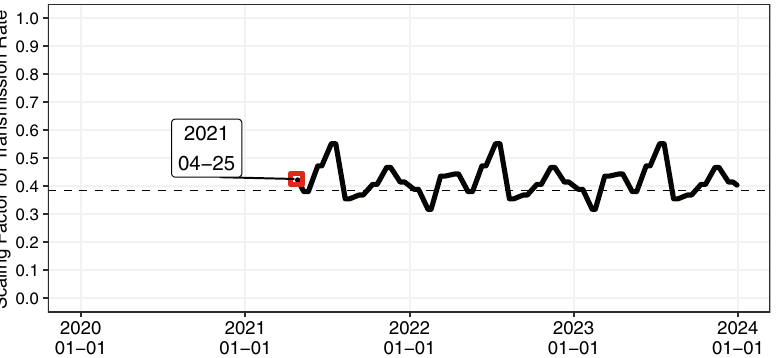
Figure 1. Simulation settings of the effectiveness of the non-pharmaceutical interventions. The simulations were started on April 25, 2021. The dashed line 1 / R 0 corresponds to an effective reproduction number with the value of one. The effective reproduction number in Tokyo, which was calculated and provided by the Toyo Keizai Inc. 48 , was used to estimate the effectiveness of the NPIs.